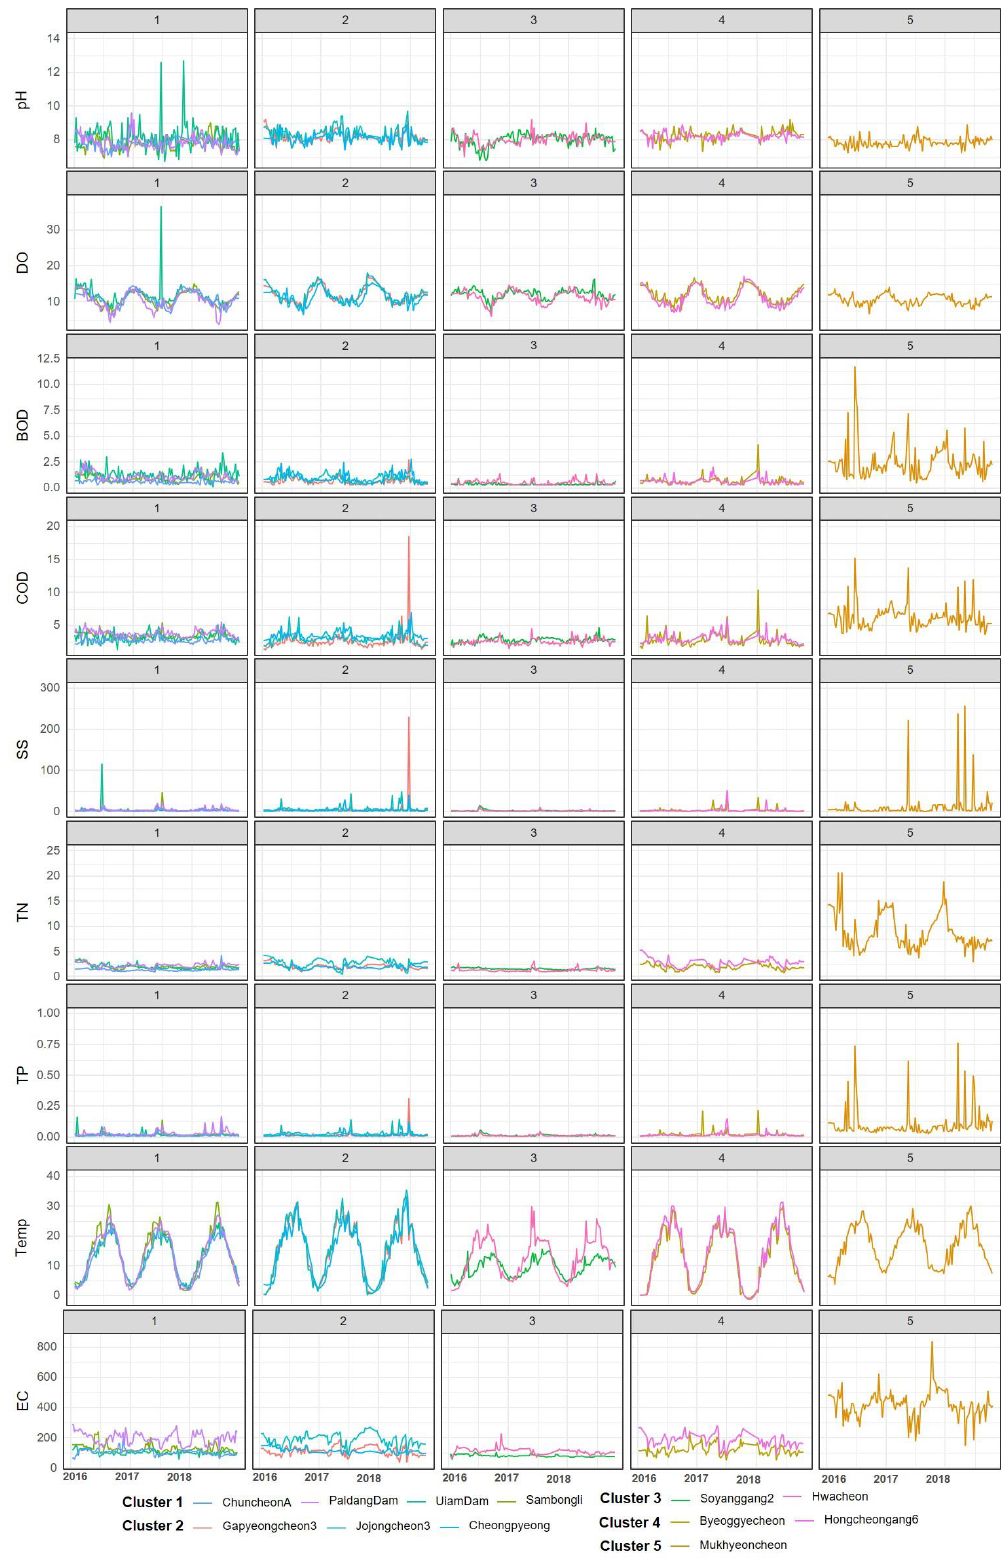
Figure 9. Cluster-specific time series plots for each variable observed between 2016 and 2018 when using the Dynamic Time Warping (DTW) algorithm about Cluster 1 (1), Cluster 2 (2), Cluster 3 (3), Cluster 4 (4), and Cluster 5 (5).